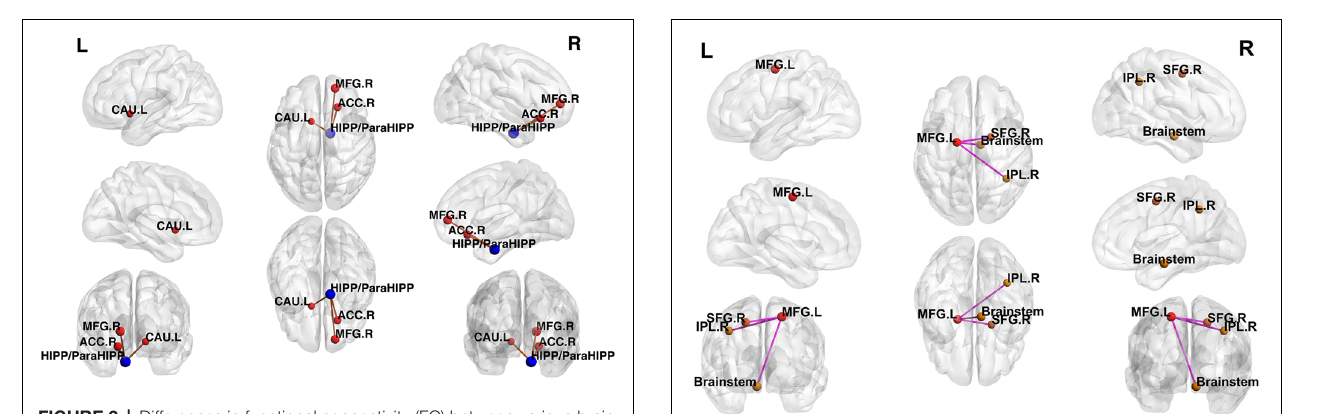
FIGURE 2 | Differences in functional connectivity (FC) between various brain regions between patients with active-stage UC and HCs. The peak level threshold was set to p = 0.001, and the cluster level FDR-corrected threshold was set to p < 0.05. The FC between the seed point and left caudate nucleus (CAU.L) used the small volume correction (SVC)-corrected p value familywise error (FWE-corrected p < 0.05). The blue node was the seed point and all the FC strengths were increased.